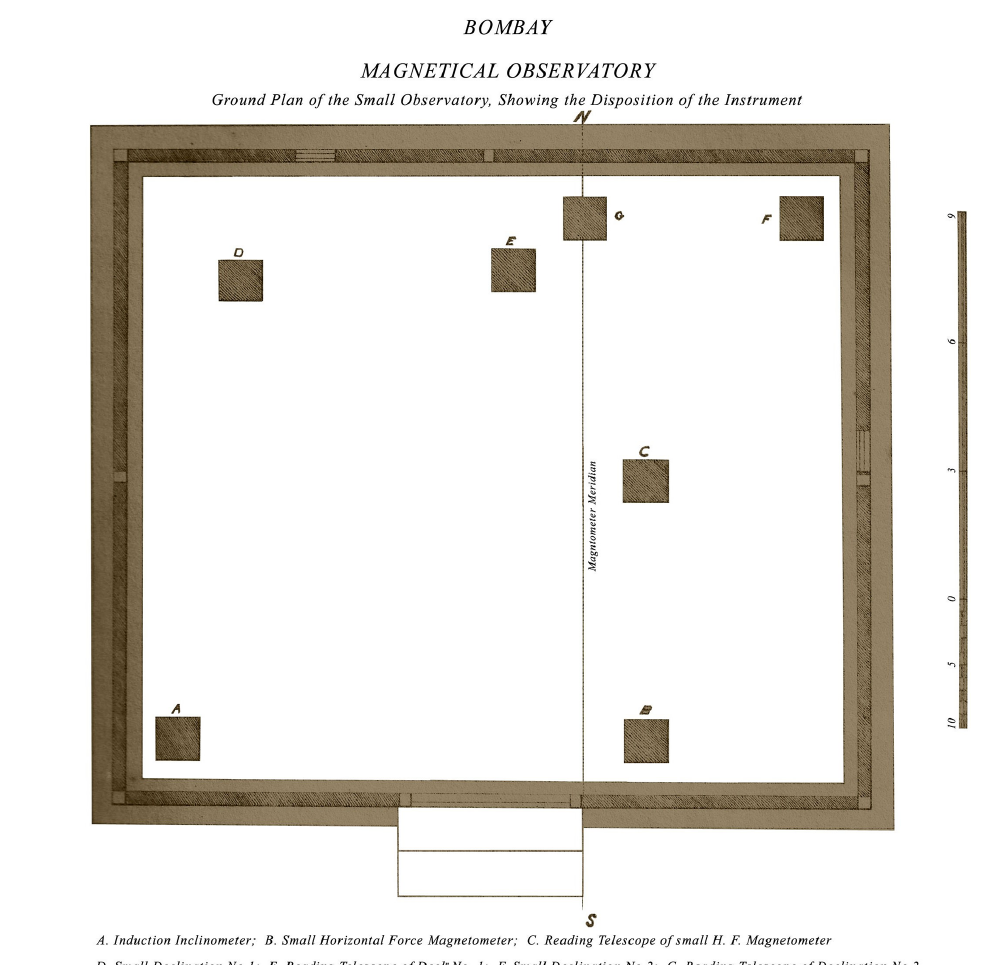
Figure 5. The arrangement and placement in a small observatory of magnetometers, induction inclinometers and other instruments (Orlebar,